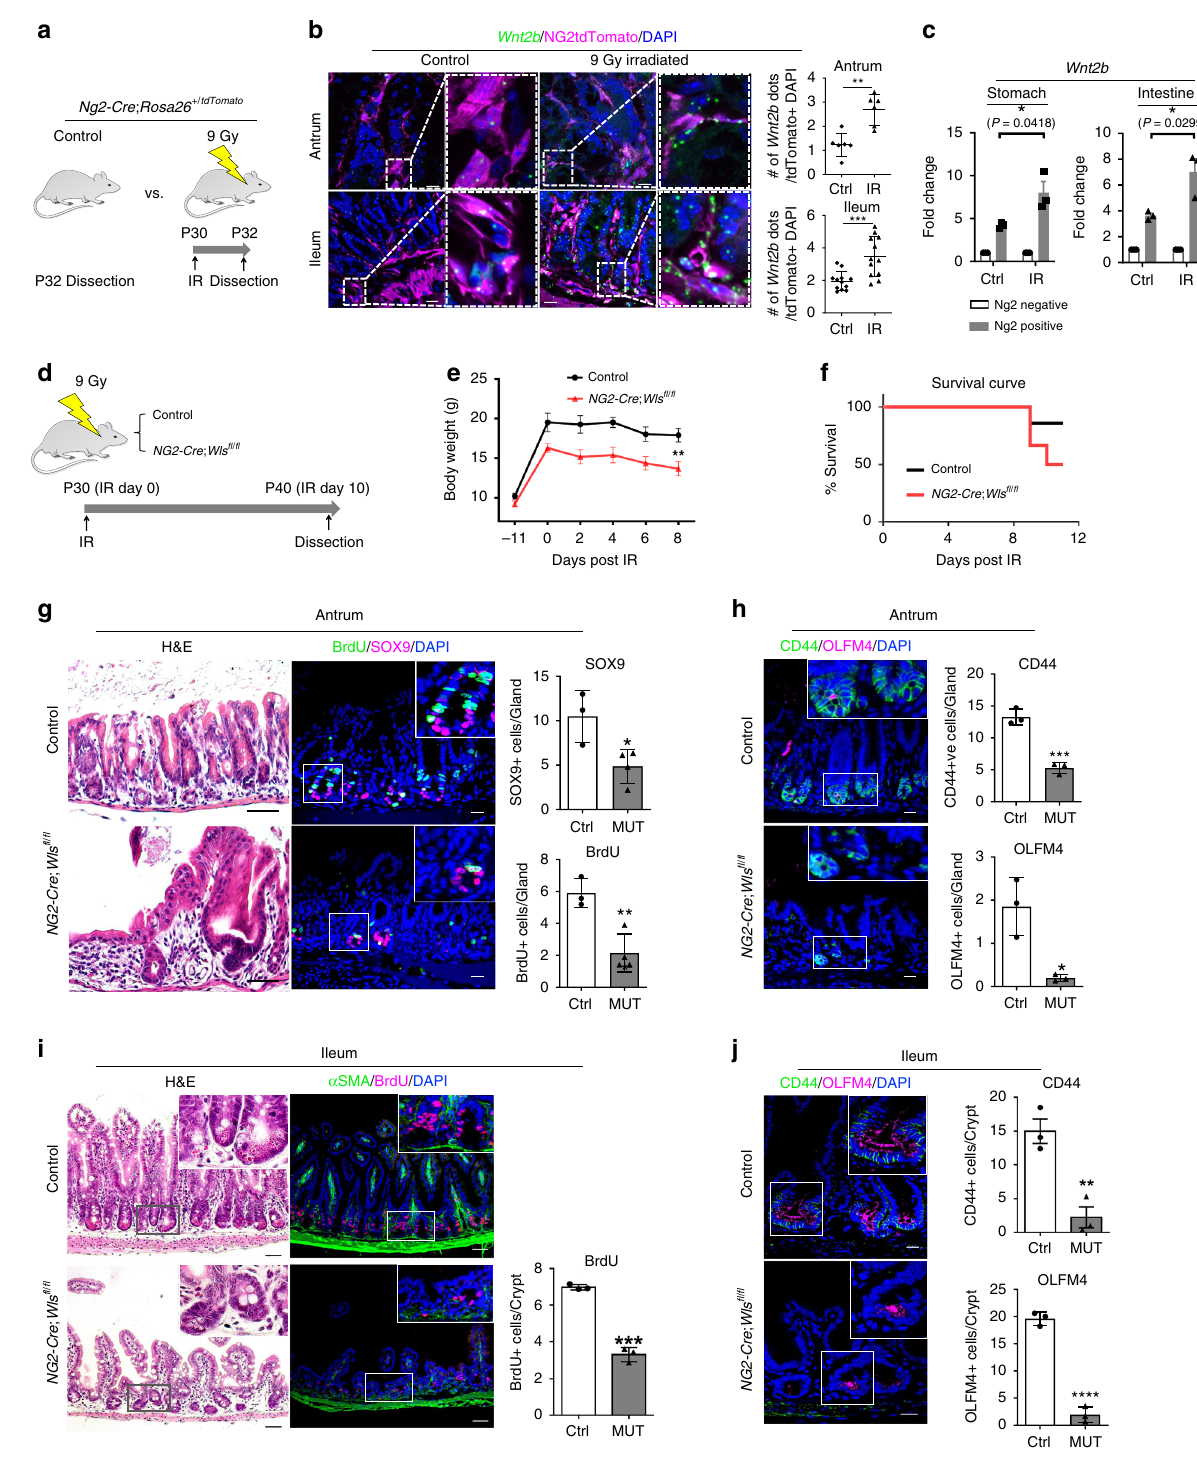
(Fig. 3e; Supplementary Fig. 22), and they were able to breed properly, suggesting additional sources of niche signals. Support- ing this notion, other stromal cell populations not labeled by Ng2-Cre expressed Wnt ligands (Supplementary Fig. 11). Given the proximity of the pericyte-like stromal cells to gastrointestinal epithelial stem cells, their expression of Wnt ligands and the role of Wnt signaling in stem cell renewal 7 , we hypothesized that